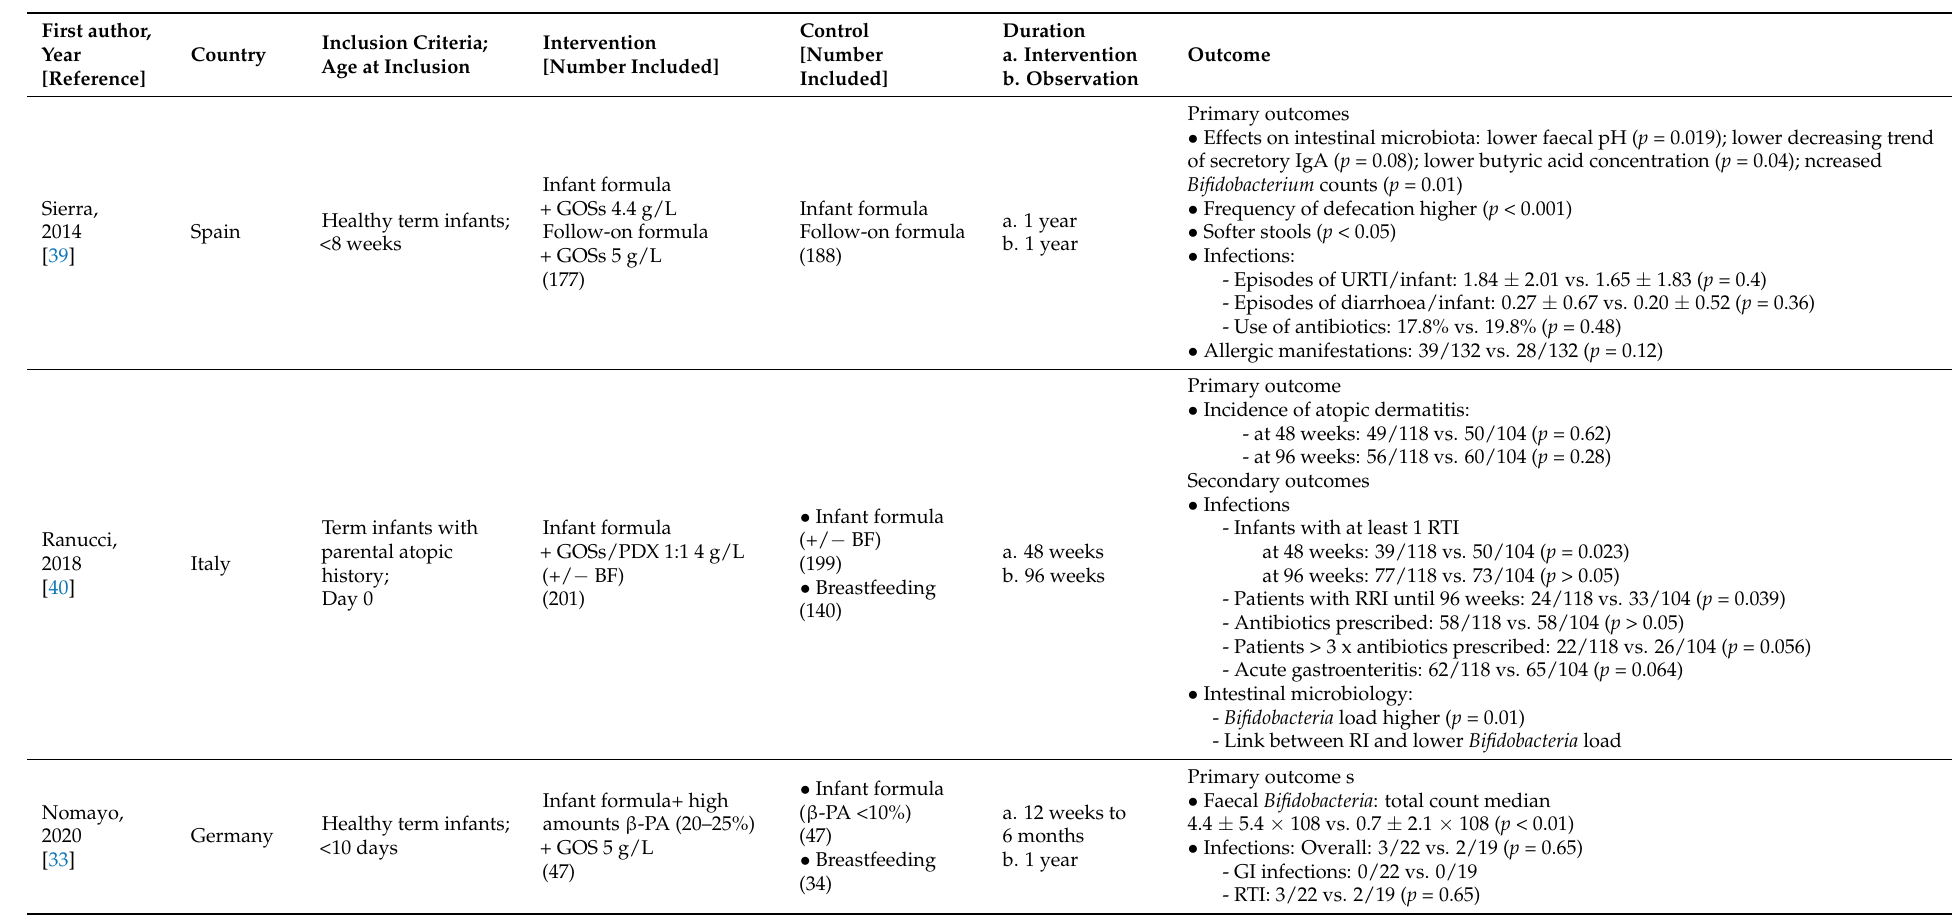
Table 4. Overview of references with other